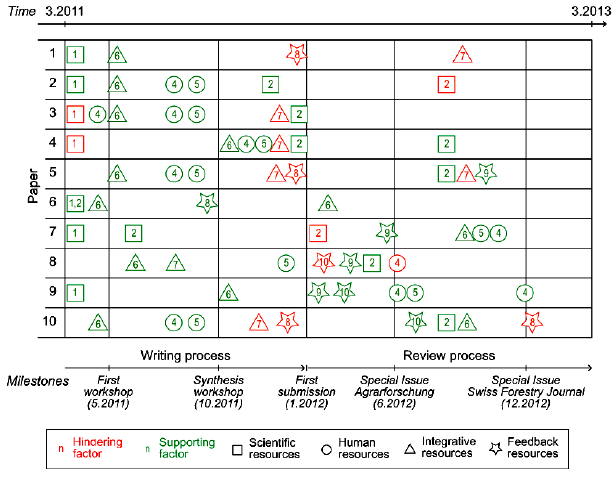
Fig. 1 . Storywalls of the 10 “Mountland” papers representing the process of publishing the Special Feature (numbers refer to the factors described in Table